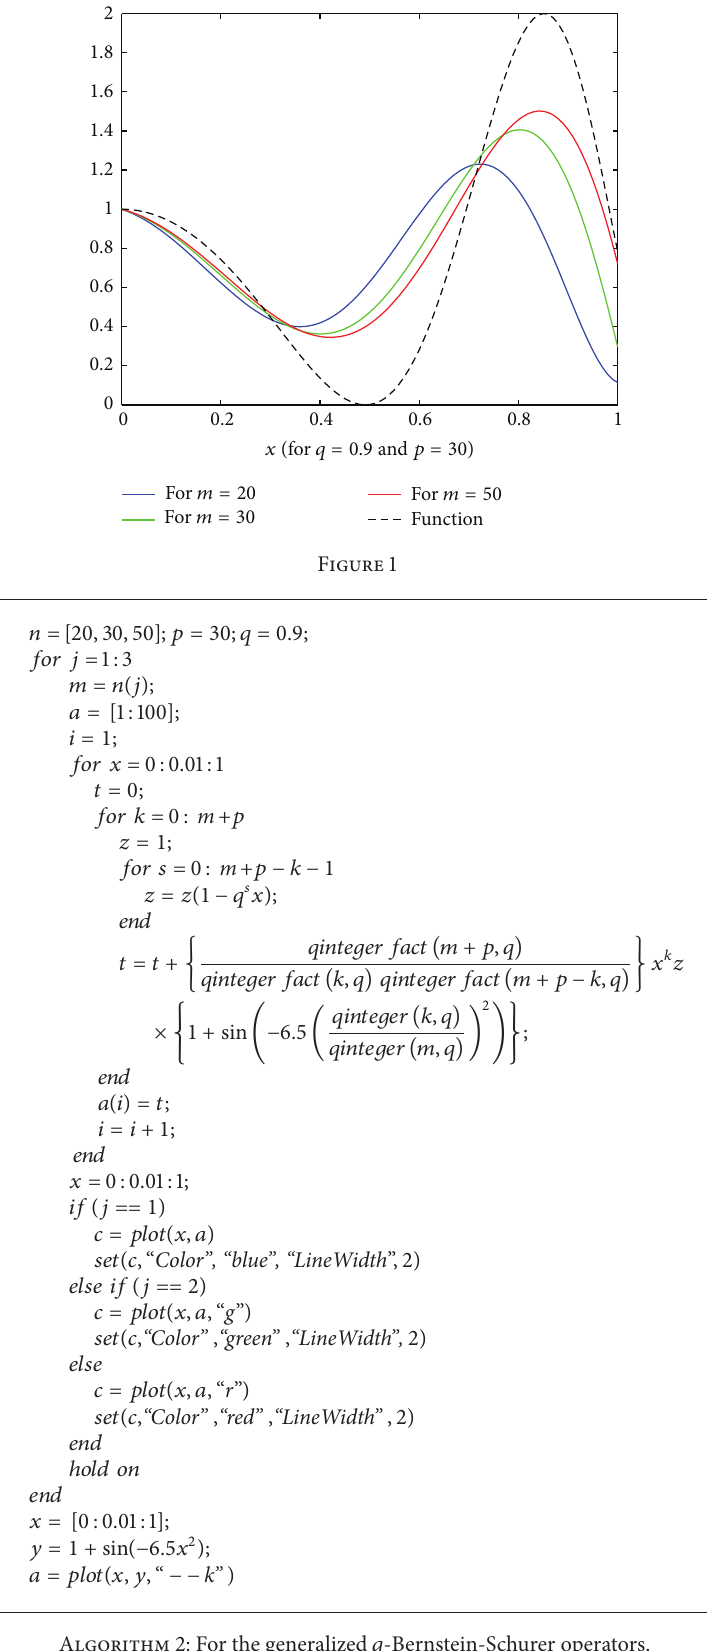
Algorithm 2: For the generalized 𝑞 -Bernstein-Schurer